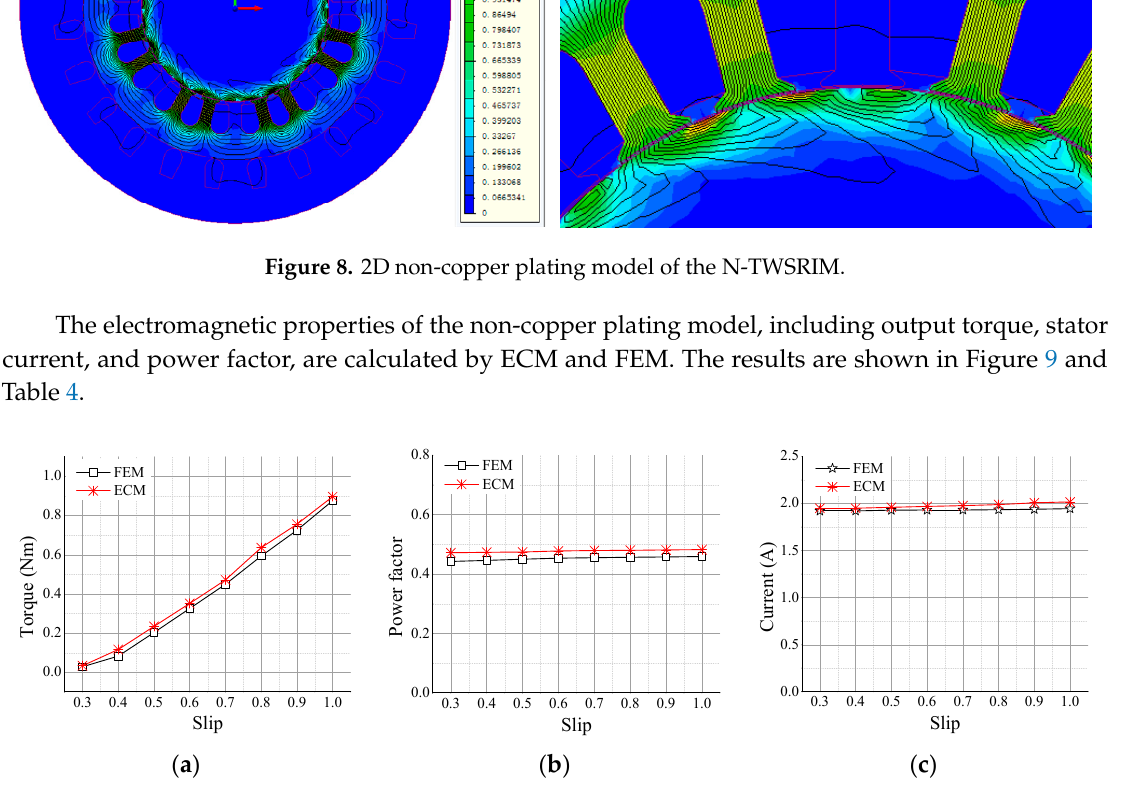
Figure 9. Comparative results of equivalent circuit model (ECM) and finite element method (FEM): ( a ) torque against slip, ( b ) power factor against slip rates, ( c ) stator current against slip. Table 4. Output torque, power factor, and stator current against slip.